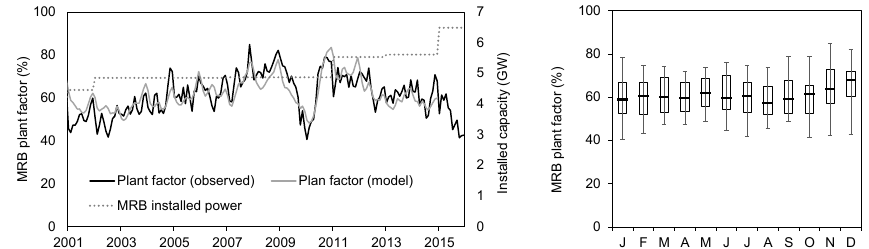
Figure 3. Aggregated observed and modeled plant factor of Magdalena River basin (MRB) hydropower plants (2001–2015), and seasonal variation of the plant factor over the observed